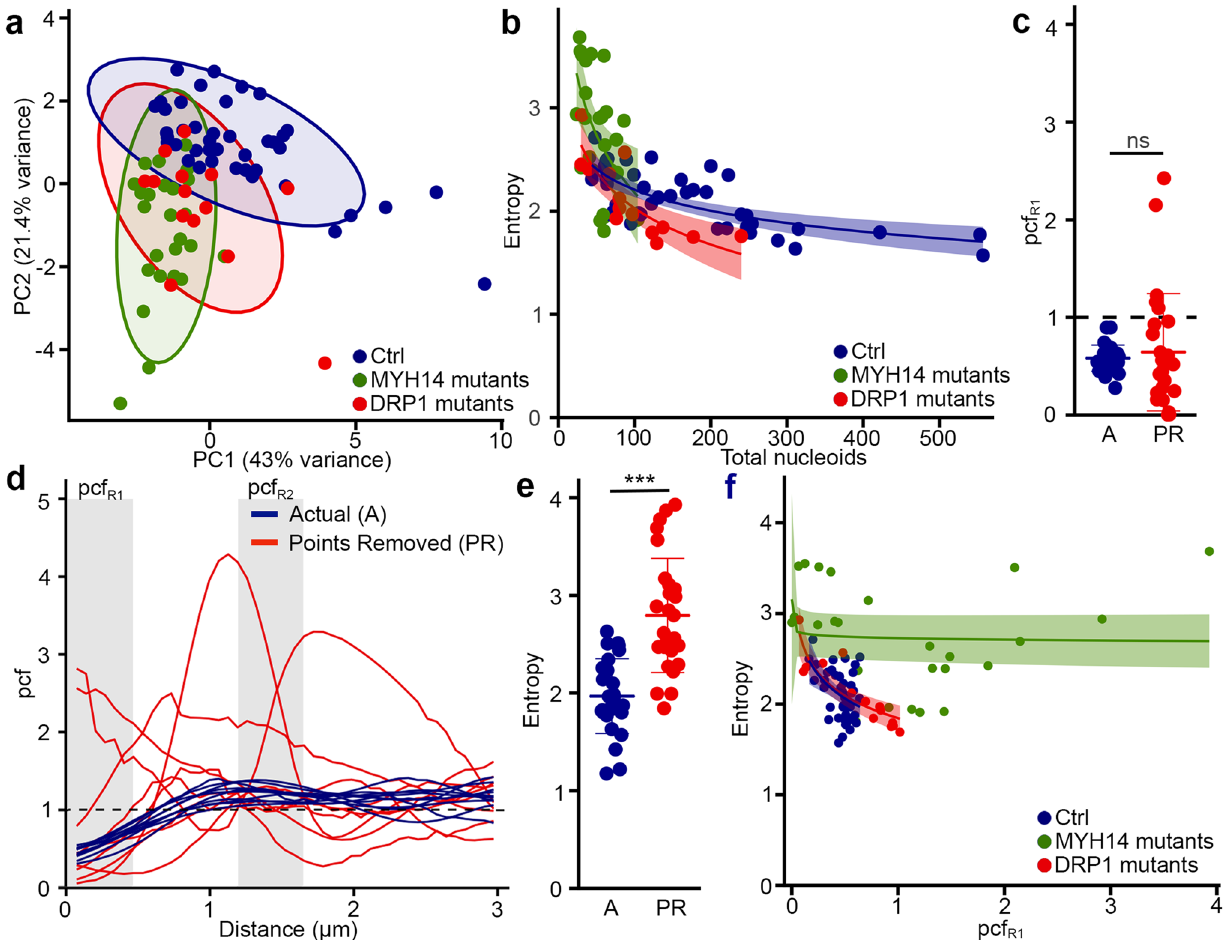
Figure 7. Nucleoid density influences the variability of the pcf curves (Entropy) across genotypes. ( a ) PCA analysis showing the segregation of mutant and control lines. Each data point represents one cell. Circles represent the 95% confidence interval ( b ) Dot plots showing the correlation between Entropy and total number of nucleoids for each genotype. The shaded areas represent the 95% confidence interval. Each data point represents one cell. ( c – e ) Decreasing nucleoid density in control cells recapitulates the pcf variability found in fission mutants. Individual cells are shown for pcfR1 values ( c ), pcf curves ( d ) and Entropy ( e ). ns. not significant, p = 1.122e−07, two-sided t-test. ( f ) Relationship between pcfR1 and Entropy in different genotypes. The shaded areas represent the 95% confidence interval. Each data point represents one